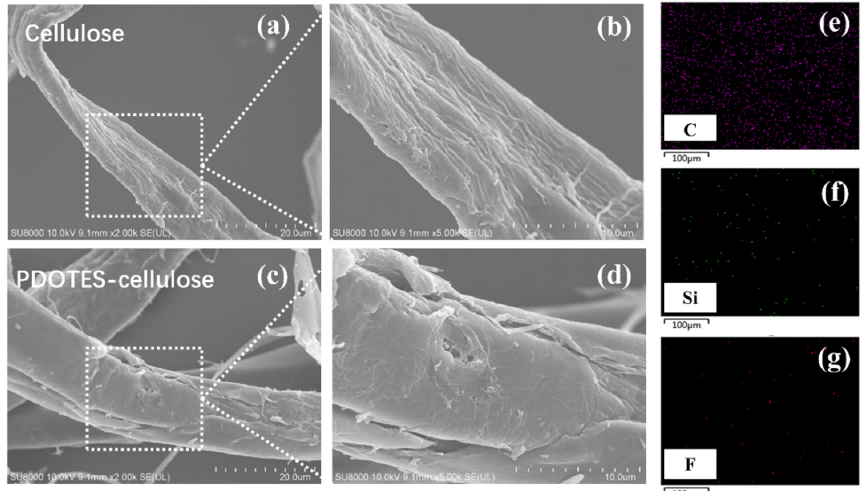
Figure 6. SEM images at different magnifications: ( a , b ) Cellulose; ( c , d ) PDOTES-cellulose; ( e – g ) sur- face elemental distribution of